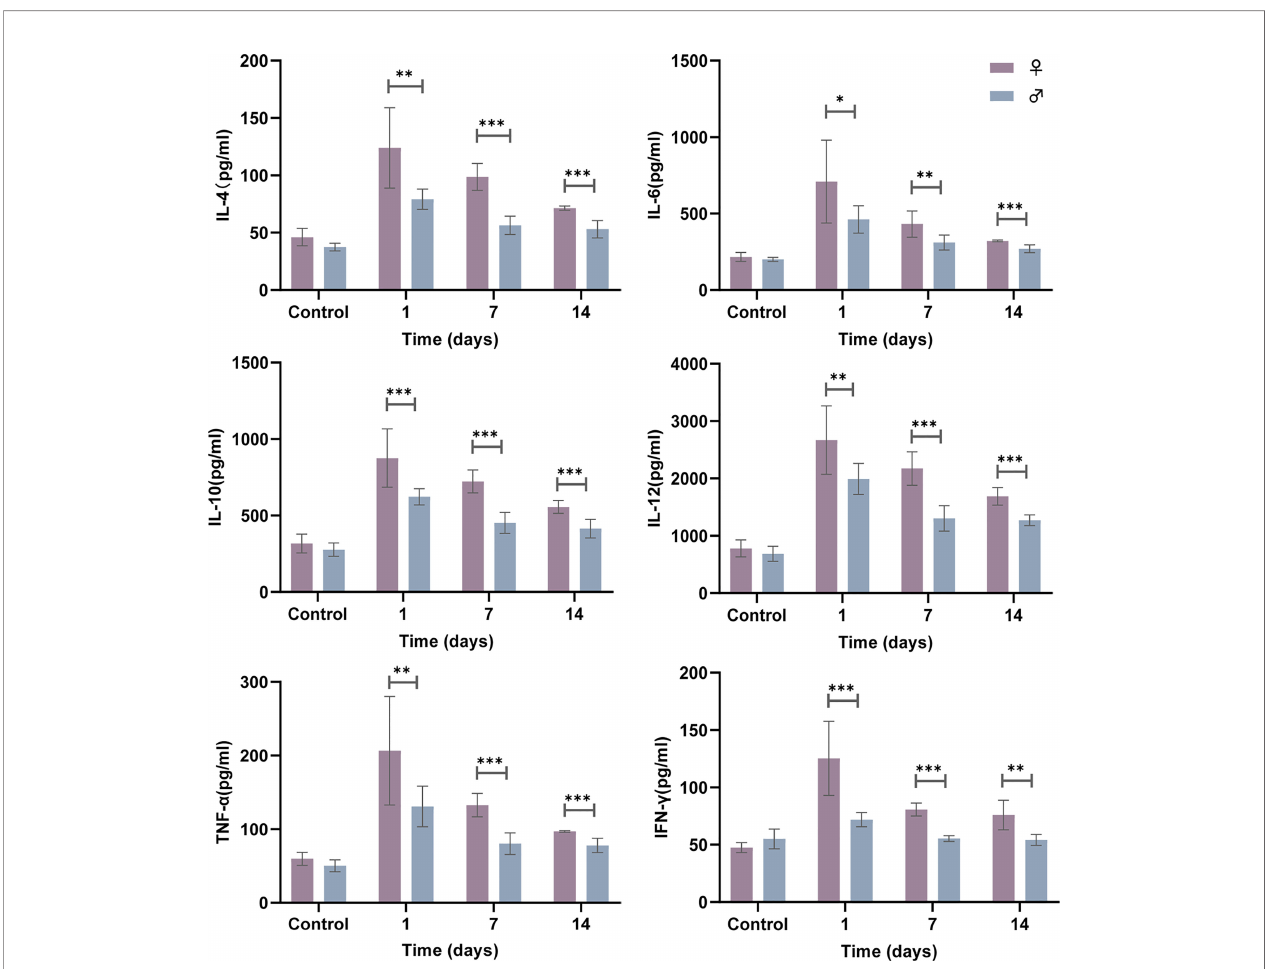
FIGURE 2 | Female mice display higher cytokine production following N. farcinica IFM 10152 infection. Female mice (n = 32) and male mice (n = 32) were infected intranasally with 1×10 7 CFU (50 µl) for 1, 7, and 14 days, or 50 µl PBS for 1 day, and cytokine levels (IL-4, IL-6, IL-10, IL-12, TNF- a and IFN- g ) in the lung supernatant were measured by ELISA. Lines display means with SEM. Data are from 2 independent experiments. * P < 0.05, ** P < 0.01, and *** P <